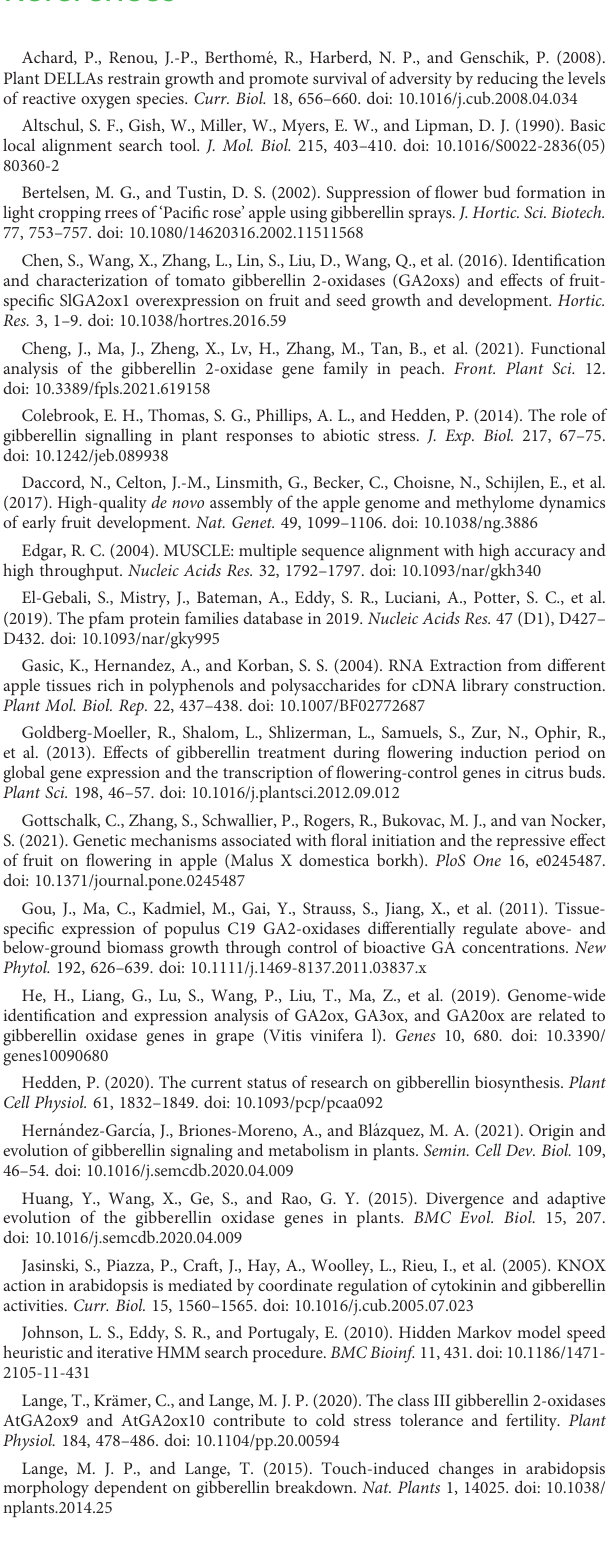
Conserved active site amino acids of the 2OG-FEII_Oxy domain catalytic core that interact with 2-oxoglutarate and Fe 2+ are highlighted in the consensus sequence in yellow and red, respectively, and denoted under the sequence with an